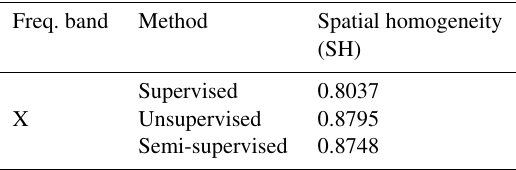
Table 4. MXPol X-band radar – comparison of semi-supervised ap- proach with its supervised and unsupervised counterpart, spatial ho- mogeneity.